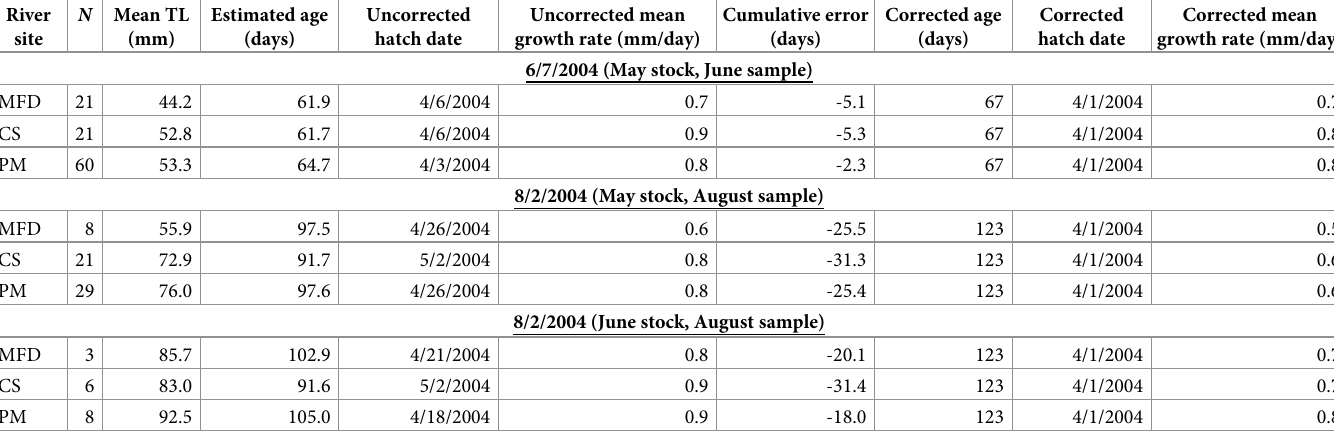
Table 1. Age-based metrics of Shoal Bass reared in hatchery ponds and stocked at three sites in the Chattahoochee River, Georgia in 2004. River site